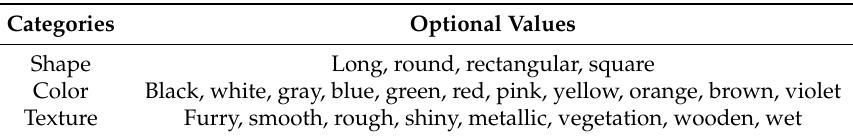
Table 3. Attributes of non-human objects.